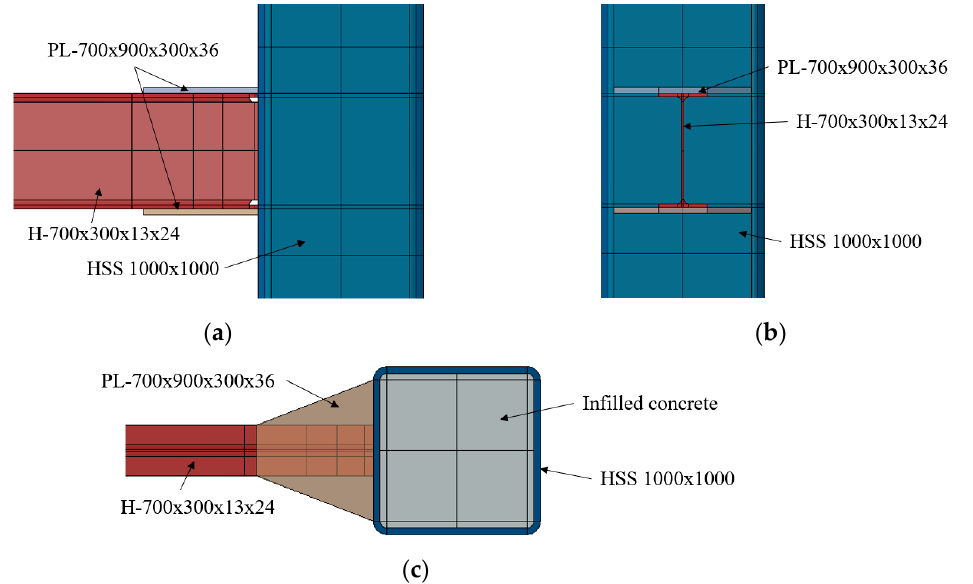
Figure 2. Details for plate-reinforced connection using large concrete-filled tubular (CFT) column. ( a ) Side view; ( b ) front view; ( c ) top view.